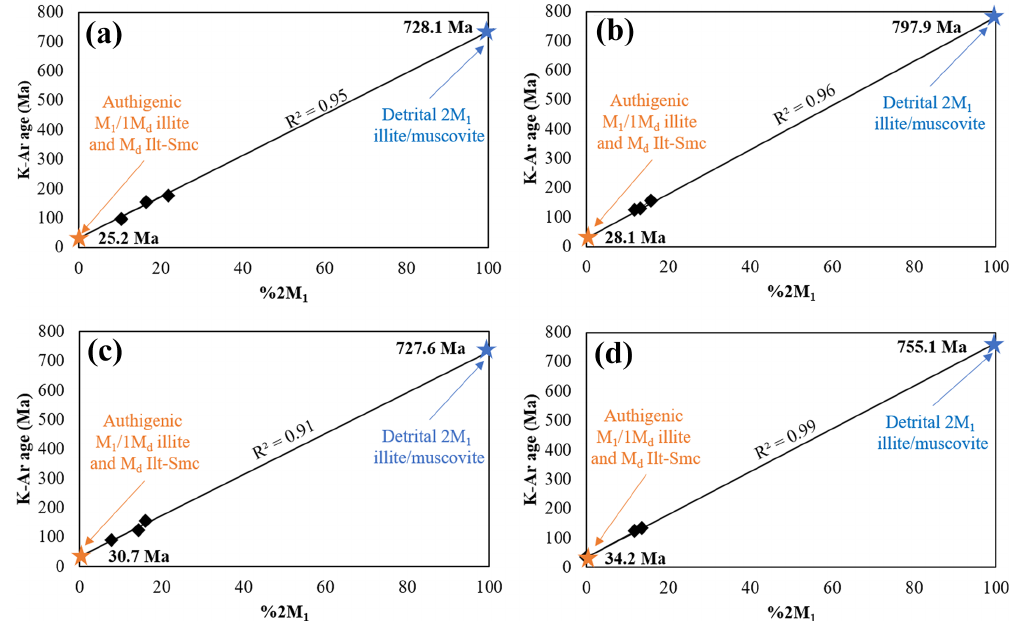
Figure 5. Crystallization ages of detrital 2M 1 illite/muscovite and of authigenic 1M d / 1M illite and illite–smectite (Ilt–Smc) from the Valley of Lakes, calculated for sediments collected from the (a) TAT section ( ∼ 90 . 5m), (b) TGR-C section ( ∼ 78 . 0m), (c) SHG-D section ( ∼ 55 . 5m) and (d) TGR-AB section ( ∼ 35 . 0m) using illite polytype quantification and K–Ar age systematics of different grain size subfractions (from left to right: < 1, 1–2 and